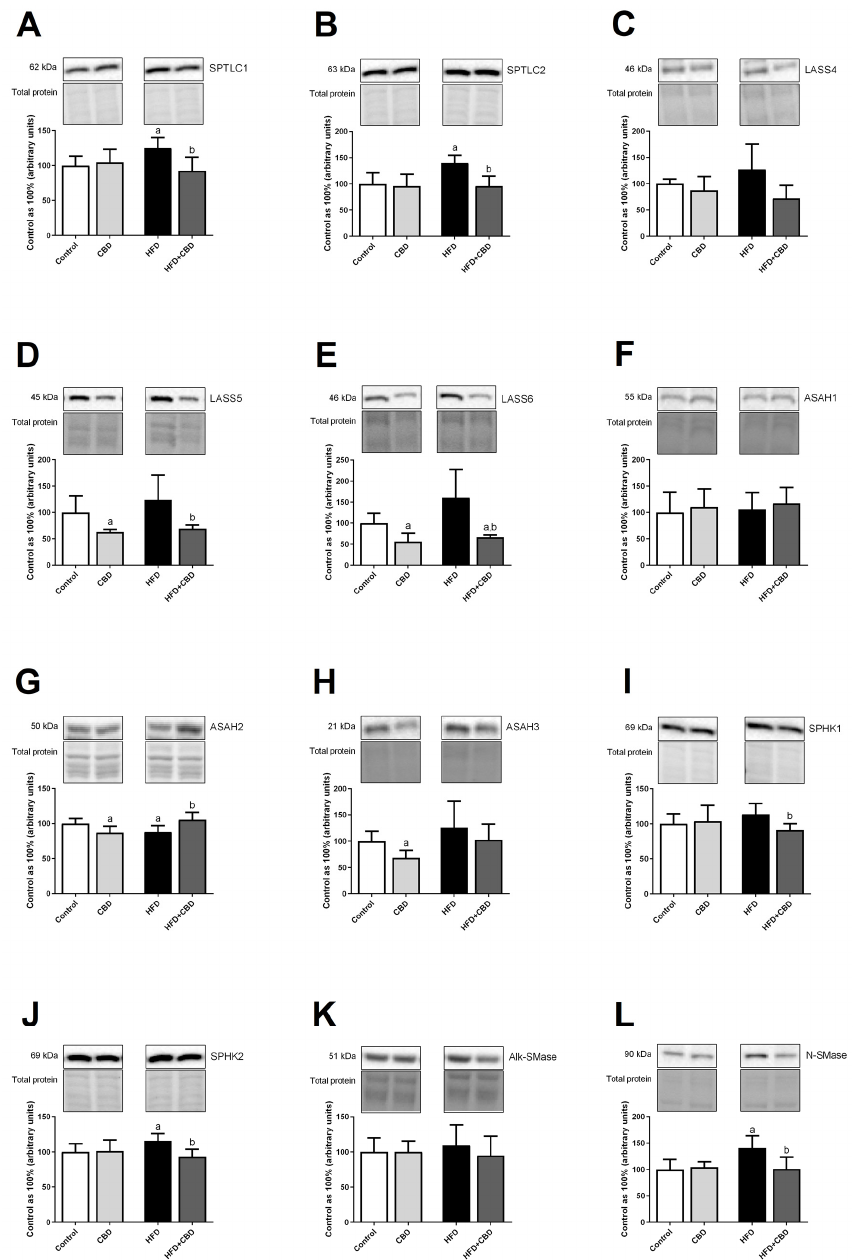
Figure 5. The total myocardial expression of the enzymes involved in the sphingolipid metabolism, i.e., serine palmitoyltransferase, long chain base subunit 1—SPTLC1 ( A ), serine palmitoyltrans- ferase, long chain base subunit 2—SPTLC2 ( B ), ceramide synthase 4—LASS4 ( C ), ceramide synthase 5—LASS5 ( D ), ceramide synthase 6—LASS6 ( E ), acid ceramidase—ASAH1 ( F ), neutral ceramidase—ASAH2 ( G ), alkaline ceramidase—ASAH3 ( H ), sphingosine kinase 1—SPHK1 ( I ), sphingosine kinase 2—SPHK2 ( J ), alkaline sphingomyelinase—Alk-SMase) ( K ), and neutral sphingomyelinase—N-SMase ( L ) in the left ventricle homogenates after 2-week cannabidiol (CBD) administration in rats fed a standard diet (Control) or a high-fat diet (HFD). The protein expression was determined by Western blotting method, normalized to the total protein loading in each lane, and presented as a percentage difference in comparison to the control group, which was set at 100%. The results are expressed as mean values ± SD and are based on six independent determinations in each group. a p < 0.05 significant difference vs. control group; b p < 0.05 significant difference vs. high-fat feeding